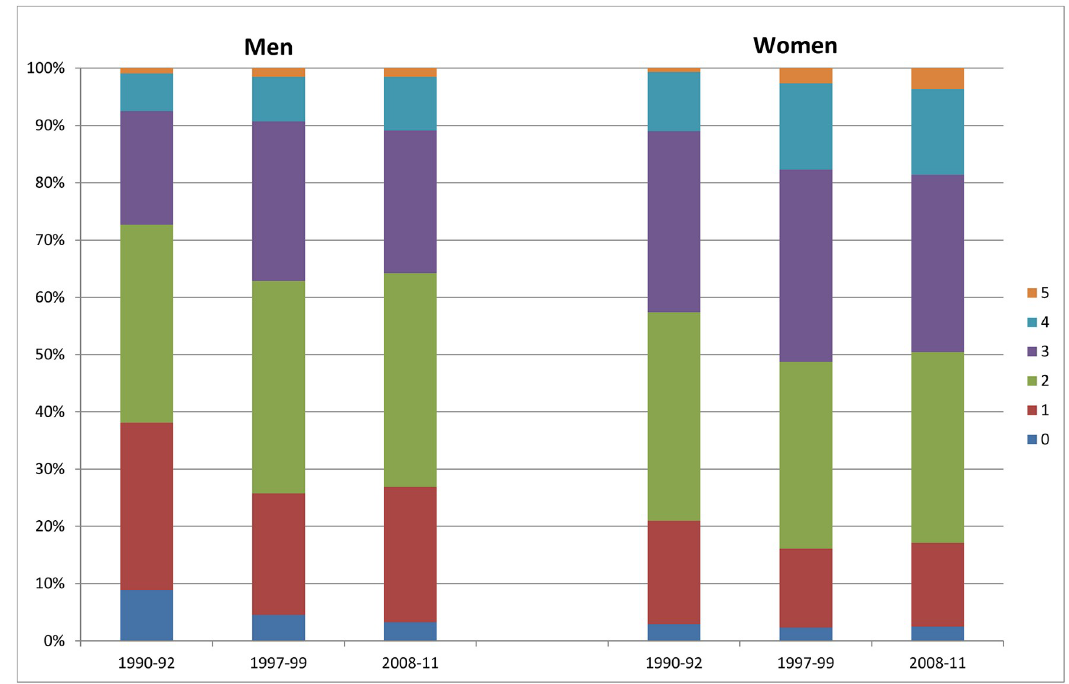
Fig 2. Proportions of specific numbers of healthy behavior factors among men and women aged 25–69 years.